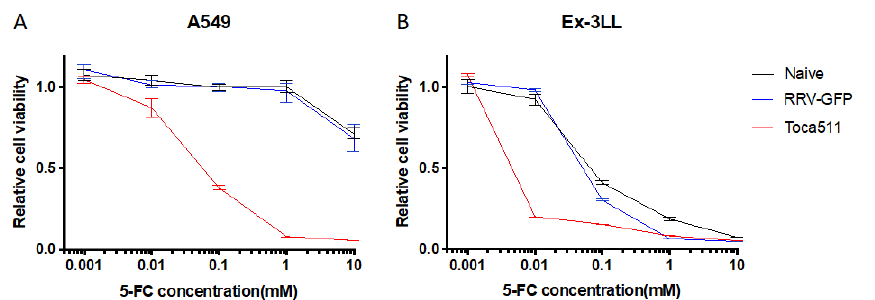
Figure 2. Cytotoxicity after 5-FC prodrug treatment in uninfected (naïve), RRV-GFP-infected, and Toca 511-infected A549 ( A ) and Ex-3LL cells ( B ) in vitro. Cell viability was measured by MTS assay after incubation with different concentrations of 5-FC, as shown, for 4 days. Data are reported as the percentage (mean ± SD) of viable cells, normalized to uninfected control cells without prodrug.